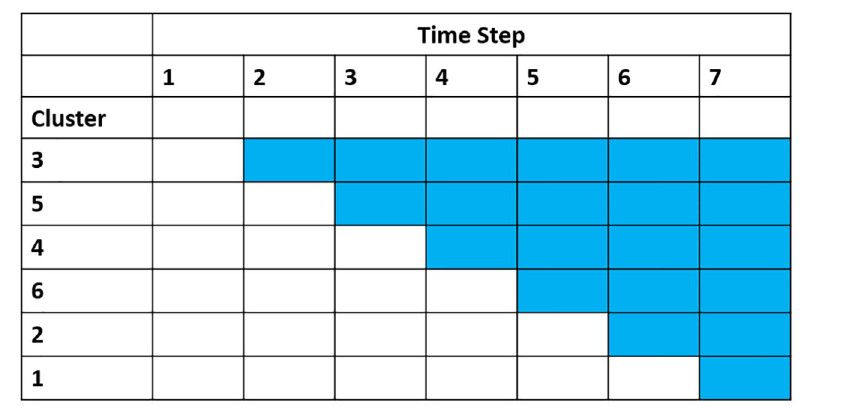
Fig 2. Graphical representation of the standard stepped wedge design intervention